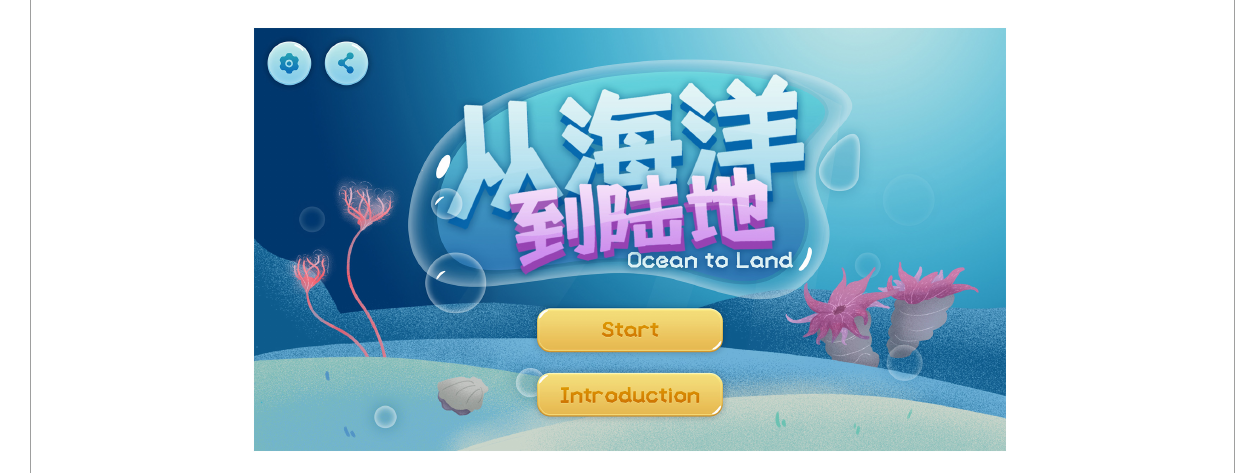
FIGURE4 “Ocean to Land” game home page.